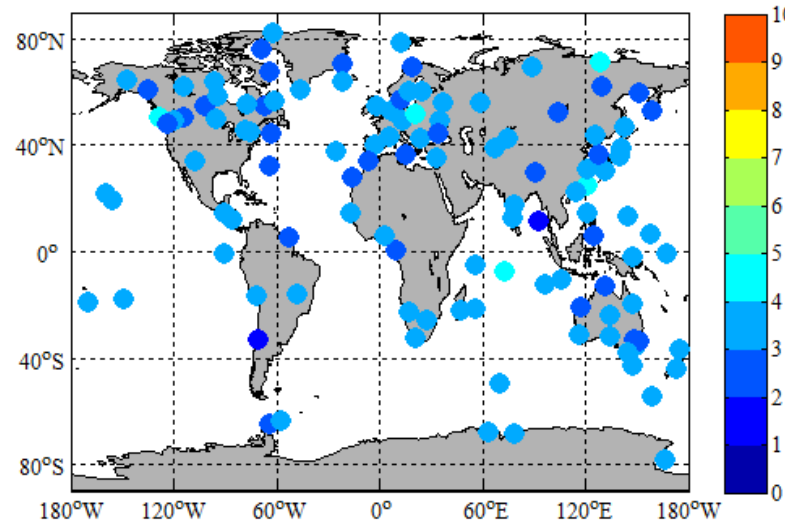
Figure 10. Distribution and 30-day RMS between the international Global Navigation Satellite System Monitoring and Assessment System (iGMAS) and IGS ZTD products of 130 IGS stations.